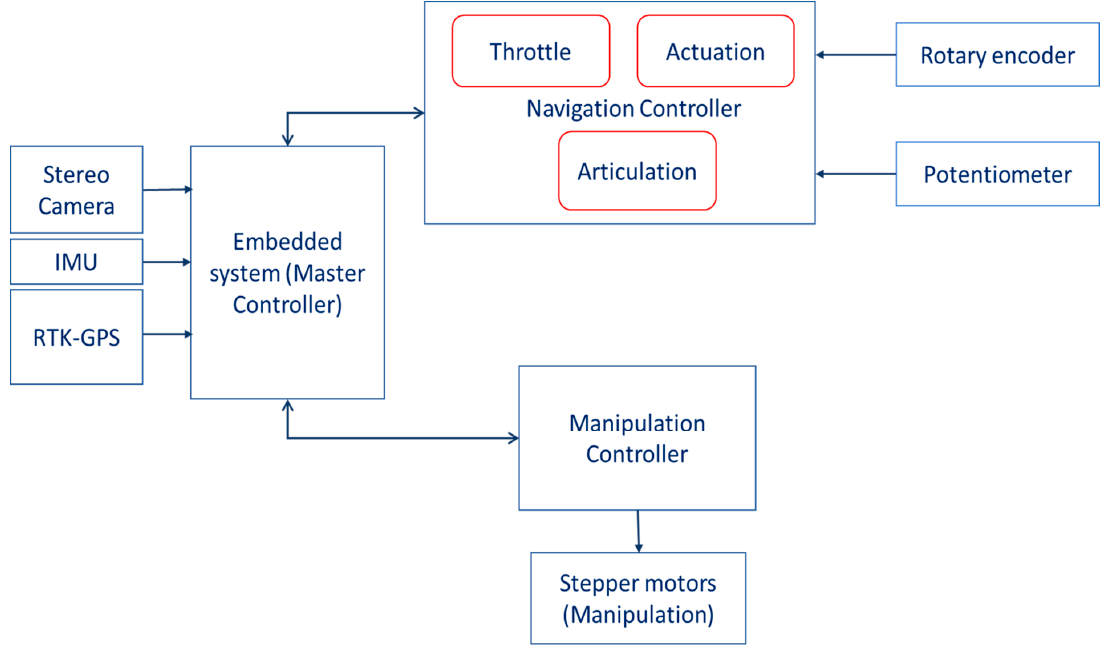
Figure 3. A contextual block diagram of the robotic system hardware. The Inertial Measurement Units (IMUs) were publishing at the rate of 120 Hz, Real-Time Kinematic (RTK)–GPS at 5 Hz, and stereo camera at 60 fps. The potentiometer and encoders where publishing changes only.